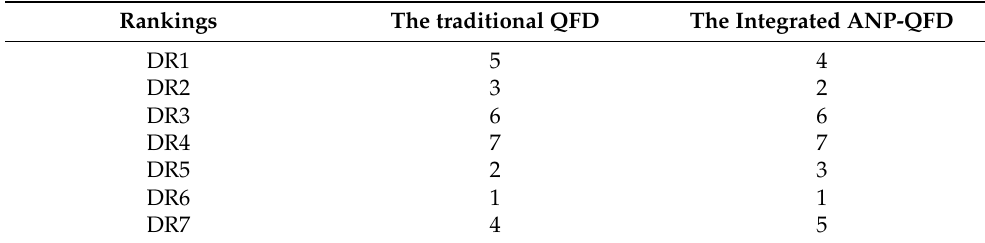
Table 12. Rankings of DRs in the traditional QFD and the integrated ANP-QFD.